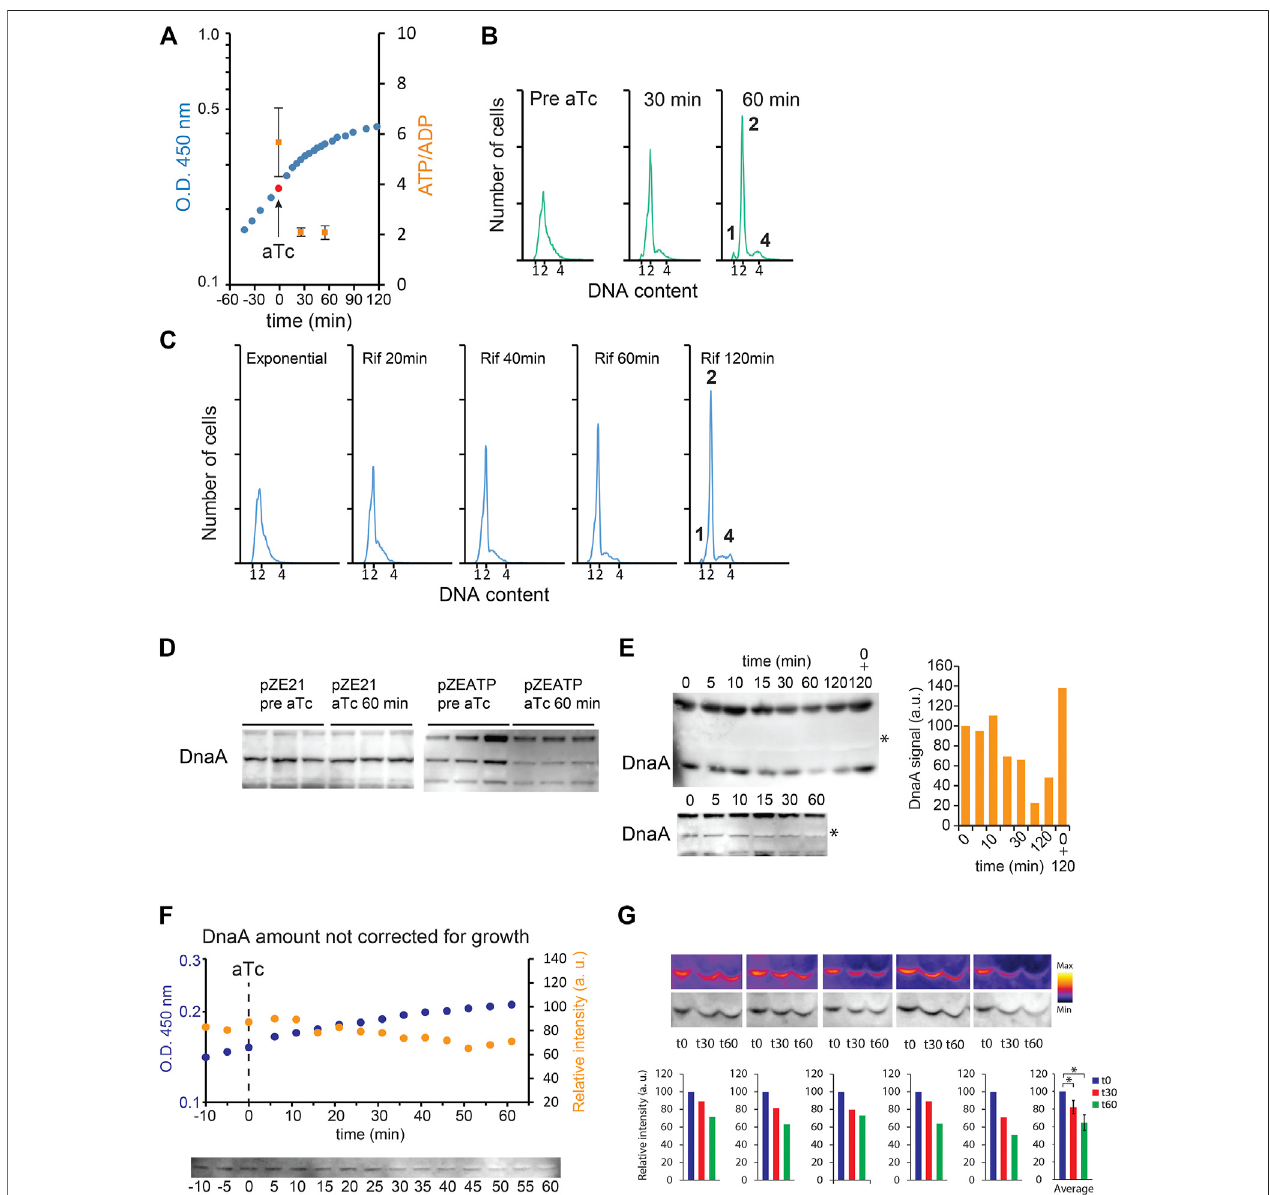
FIGURE 1 | DnaA stability during ATP starvation. E. coli grown at 37 ° C in minimal medium supplemented with 0.2% glucose. (A) Growth curve of MG1655 Z1/ pZATP.InductionofATPaseexpression with0.2 μ g/mlanhydrotetracycline(aTc)isindicatedbyanarrowandaredball.TimepointswhereATP/ADPwasmeasuredare shown inorange squares (SD+/ − (n (cid:2) 3)). (B) FlowcytometryanalysisshowingtheDNAcontentofMG1655Z1/pZATP cellstaken priortoand following additionofaTc. Histogram displaying cells 60 min after ATPase induction shows complete replication run out with 1, 2, or 4 fully replicated chromosomes. (C) Flow cytometry analysis of cells treated with 300 μ g/ml rifampicin and 36 μ g/ml cephalexin. (D) DnaA protein level prior to and following addition of aTc in MG1655 Z1/pZE21 (control plasmid) and MG1655 Z1/pZATP. Samples were taken prior to and 60 min after addition of aTc. Protein samples were corrected for total protein concentration prior to electrophoresis. (E) The DnaA protein level prior to and following addition of aTc in MG1655 Z1/pZATP. The time point at which the samples were taken is indicated. Protein samples were corrected for total protein concentration prior to electrophoresis (top, long electrophoretic separation). 0 + 120 indicates that t 0 and t 120 , samples are loaded together. * indicates unknown protein co-migrating with DnaA (bottom, shorter electrophoretic separation; right, quanti fi cation of the raw DnaA signal in the upper Western blot). (F) The DnaA protein level prior to and following addition of aTc in MG1655 Z1/pZATP without correction for total protein content. 100 μ l of culture was harvested at each time points. The samples were centrifuged, and the whole cell pellet was loaded on the gel (top, optical density measurement of the growing culture (blue) and DnaA signal intensity from Western blot analysis (orange) are plotted on the graph; bottom, corresponding Western blot). (G) The DnaA protein level prior to and following addition of aTc in MG1655 Z1/pZATP without correction for the total protein content. One ml was harvested prior to and 30 min and 60 min after addition of aTc ( fi ve independently growing cultures). The samples were centrifuged, and the whole cell pellet was loaded on the gel. Histograms show DnaA signal intensity below the corresponding Western blot and the average of the measurements ± SD (n (cid:2) 5),* (cid:2) p < 0.05.